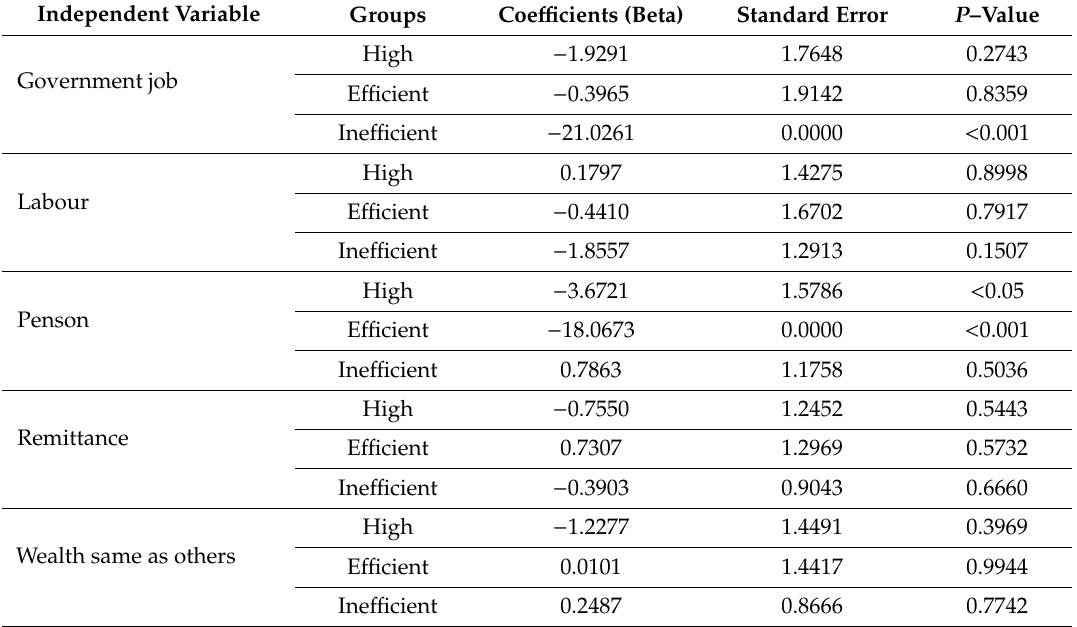
Table 6. Results of multinomial logistic